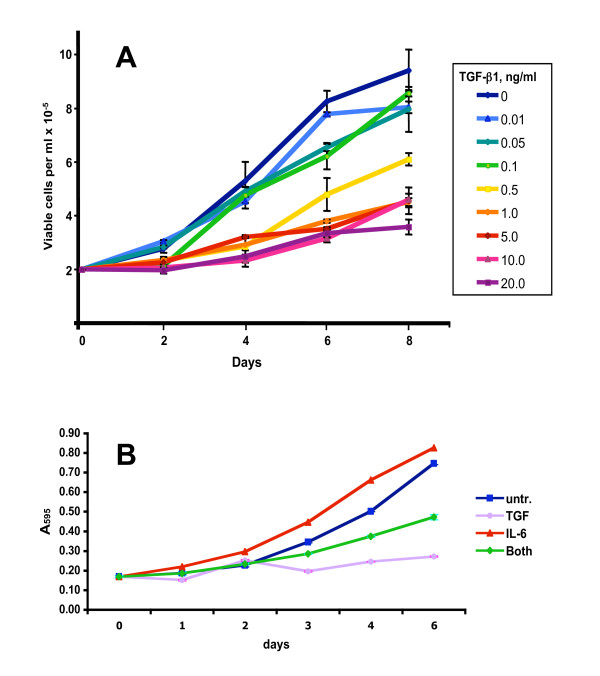
(A). Dose-dependent growth inhibition of LCL8664 cells by TGF-β1. LCL8664 cells were cultured with TGF-β1 in varying concentrations from 0 ng/ml to 20 ng/ml. Viable cell counts were determined by trypan blue exclusion at regular intervals for 8 days. (B). Positive and negative growth regulation of LCL8664 cells by TGF-β1 and IL-6. LCL8664 cells were cultured with TGF-β1 (1 ng/ml), IL-6 (20 ng/ml), both, or were untreated (untr). Cell viability was quantified over 6 days of treatment using a tetrazolium dye reduction assay.